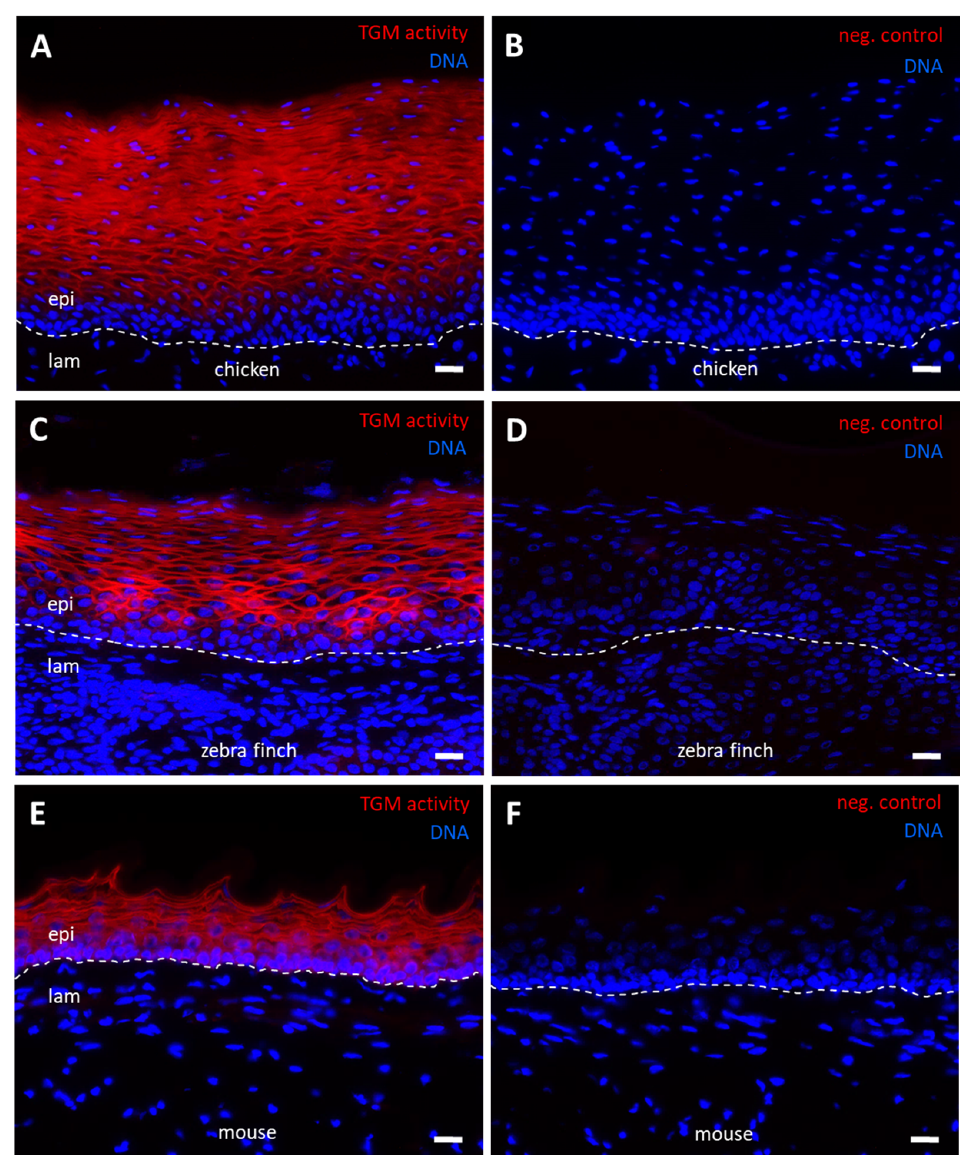
Figure 5 . In situ labeling of transglutaminase (TGM) activity in the esophagus. The esophagus of the chicken ( A , B ), zebra finch ( C , D ) and mouse ( E , F ) were cryosectioned and incubated with Alexa-fluor 555-cadaverine (red) in buffer containing either calcium ( A , C , E ) or, as negative (neg.) control, EDTA ( B , D , F ). Nuclear DNA was labeled with Hoechst 33258 (blue). The images were recorded with an Olympus BX63 microscope. The brightness of the images was increased by 60% in panels ( C , D ) and by 30% in panels E and F . White dashed lines indicate the basement membrane of esophageal epithelia. Scale bars = 20 µm. epi, epithelium; lam, lamina propria.